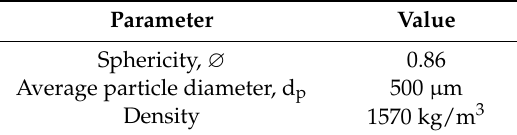
Table 10. MgCl 2 ¨ 6H 2 O particles properties